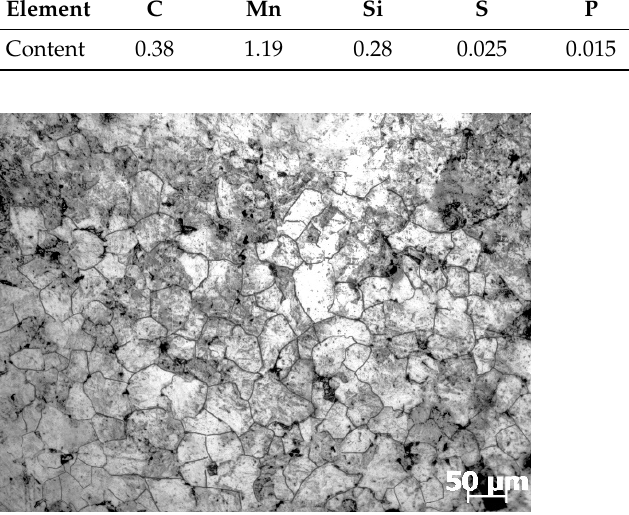
Table 1. Chemical composition (wt%) of studied SAE 5137H steel.